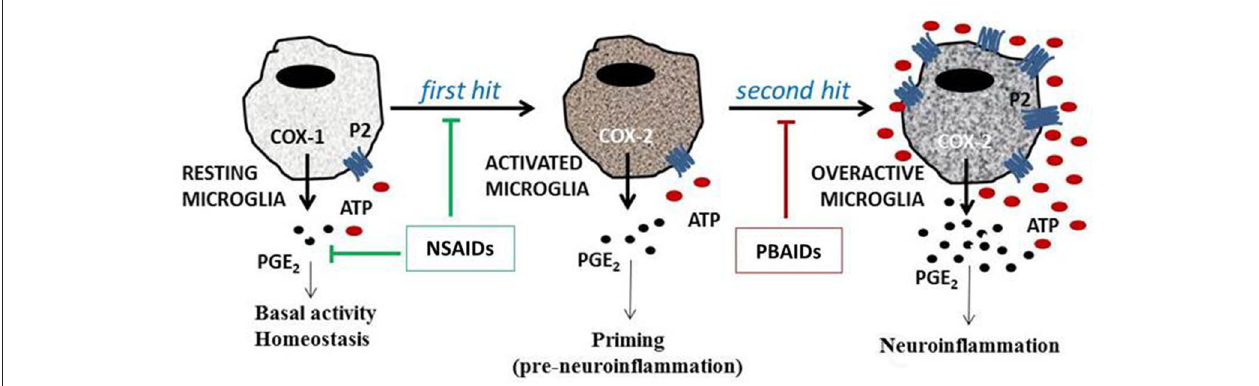
FIGURE 1 | The two-hit model of neuroinflammation . The ATP-mediated enhancement of neuroinflammation can be explained through the two-hit model. A variety of insults, such as bacterial LPS, various cytokines, or amyloid peptides, can act as the first hit , resulting in microglial activation, COX-2 induction and PGE 2 release. The second hit , following neuronal injury, death or persistent glial cell activation, results in the release of ATP,